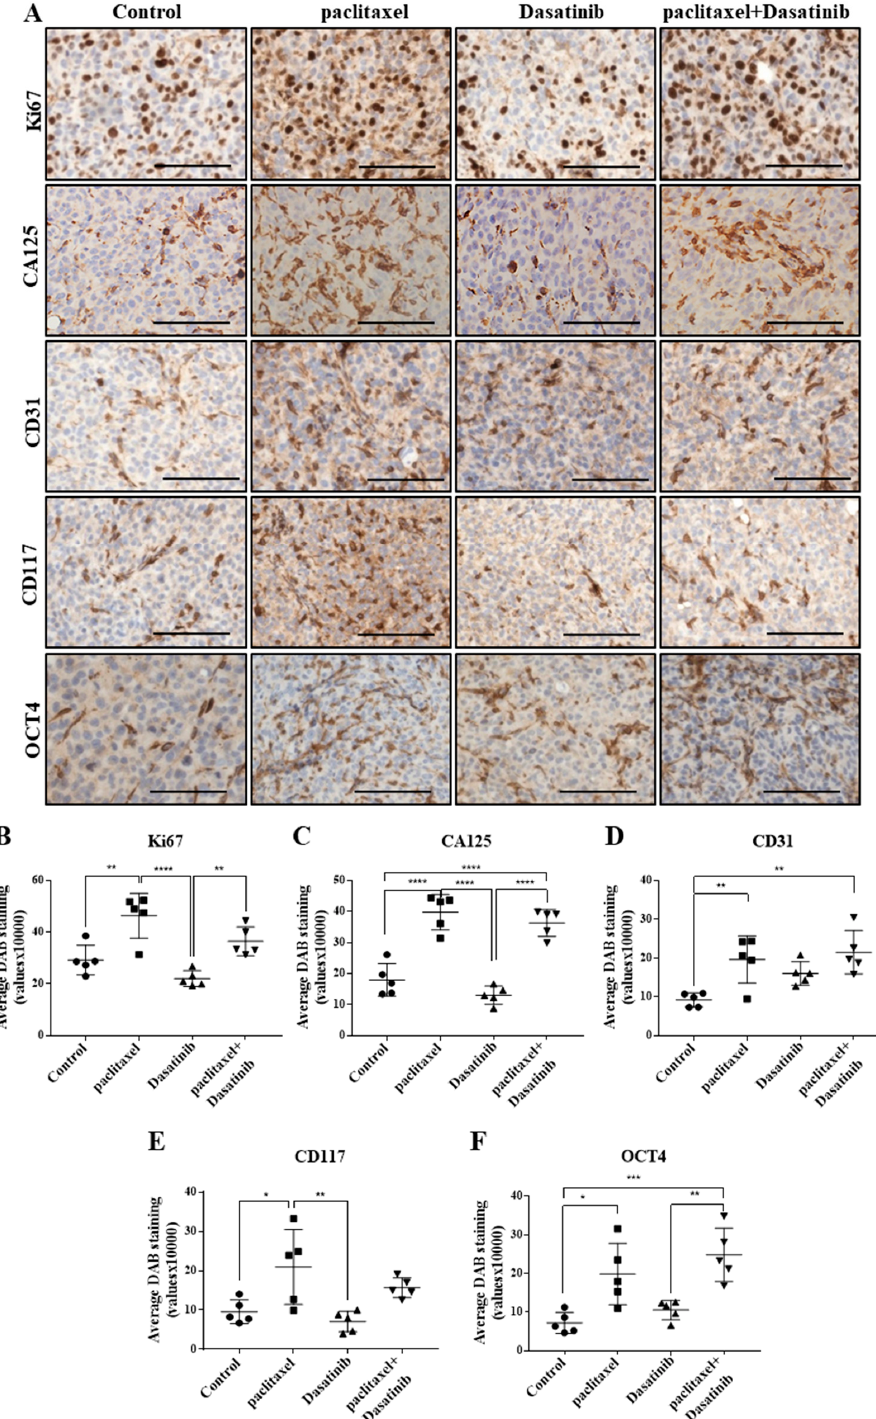
Figure 6. Dasatinib and paclitaxel combination treatment does not reduce paclitaxel-induced Ki67, CA125, CD31 or CSC marker expressions in ovarian xenografts. ( A ) Representative images of Ki67, CA125, CD31, CSC markers in HEY cell derived xenografts, post 12 days of treatment. Magnification 200× scale bar = 200 µM. Quantification of ( B ) Ki67, ( C ) CA125, ( D ) CD31, ( E ) CD117 and ( F ) OCT4 DAB staining was performed using Aperio software. Results are displayed as average DAB staining of the same samples (×10,000) ± SD. Significance is indicated by * p < 0.05, ** p < 0.01, *** p < 0.001, **** p < 0.0001.